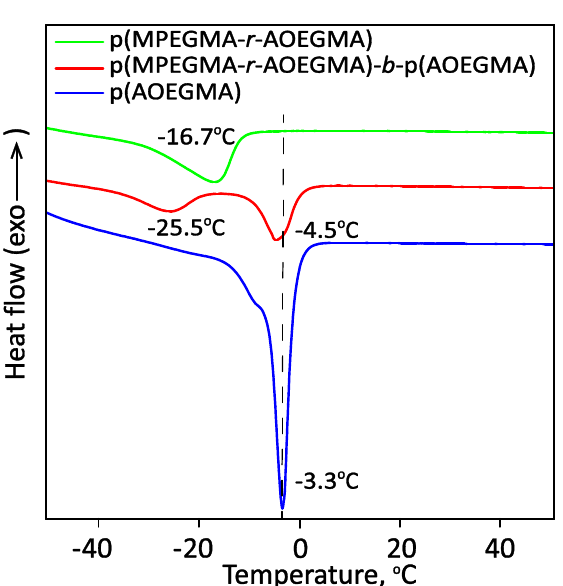
Figure 12. DSC thermograms of p(AOEGMA) (Ph13), p(MPEGMA- ran -AOEGMA) (Ph12), p(MPEGMA- ran -AOEGMA)- b -p(AOEGMA) (Ph14). Heating rate: 10